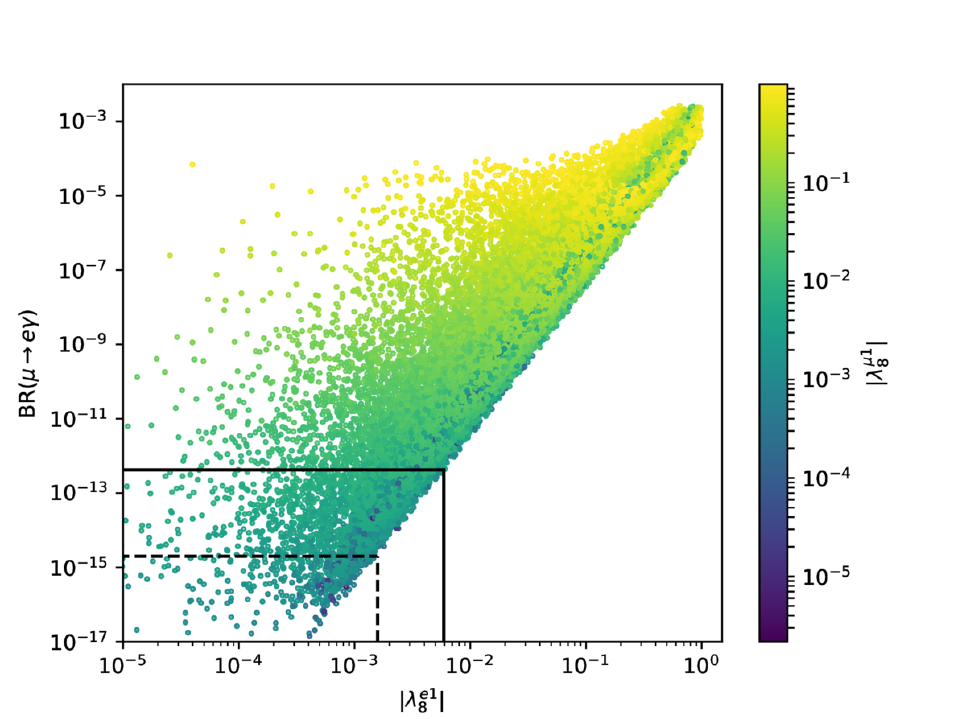
Figure 5 . Branching ratio of the lepton (cid:13)avour violating process (cid:22) ! e(cid:13) versus the DM-electron coupling (cid:21) e 1 . The DM-muon coupling (cid:21) (cid:22) 1 is shown on a colour scale. Also shown are the current 8 8 (solid black line) [69] and expected future (dashed black line) [70] limits on the branching ratio by the MEG